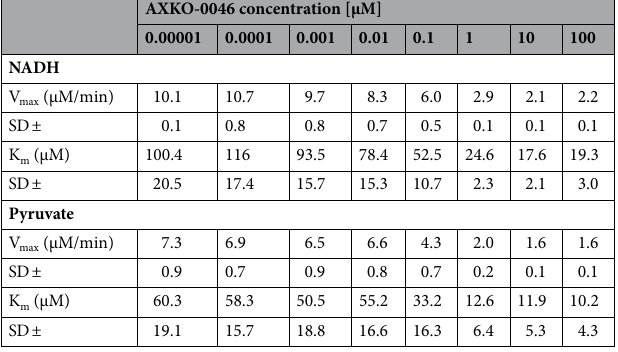
Table 1. Effects of AXKO-0046 on K m and V max of NADH and pyruvate on LDHB enzyme activity. Data shown are mean ± standard deviation (n = 3).